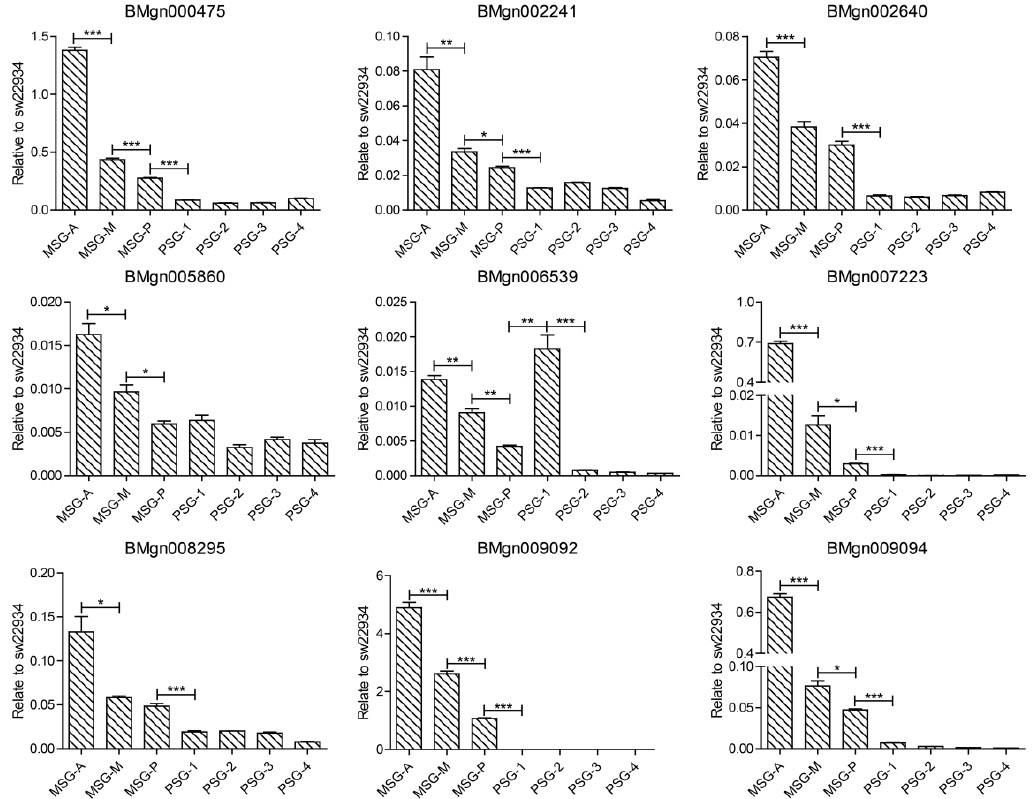
Figure 6. Quantitative PCR verification of partial gradually upregulated genes. “*” stands for p -value < 0.05, “**” stands for p -value < 0.01, and “***” stands for p -value < 0.001.